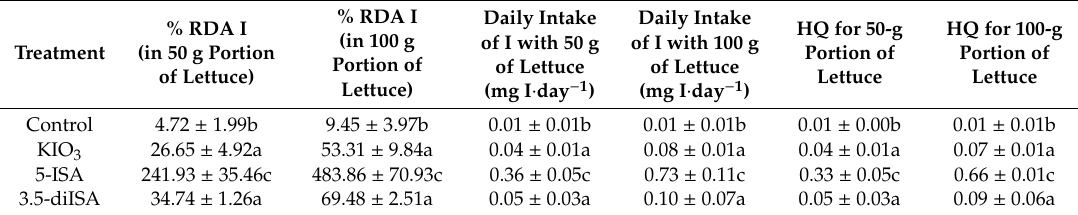
Table 7. Percentage of Recommended Daily Allowance (RDA) for iodine (RDA-I) and hazard quotient (HQ) for intake of iodine through consumption of 50 and 100 g portions of fresh lettuce leaves by adults 70 kg body weight (means for 2018–2019).